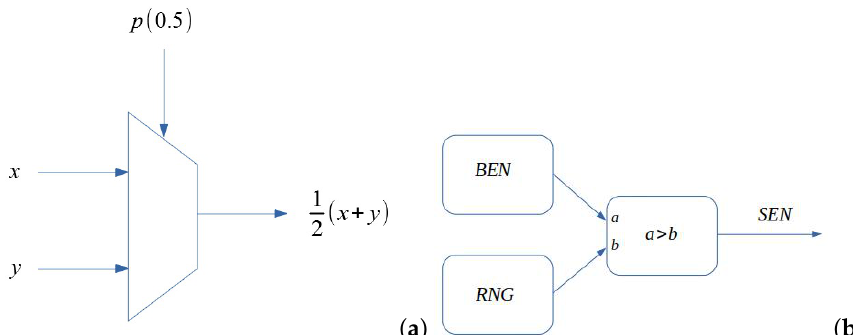
Figure 2. Basic implementation schemes ( a ) of a SC adder using a multiplexer and ( b ) a stochastic number generator (SGN) which converts a binary encoded number (BEN) to a stochastic encoded number (SEN) using a random number generator